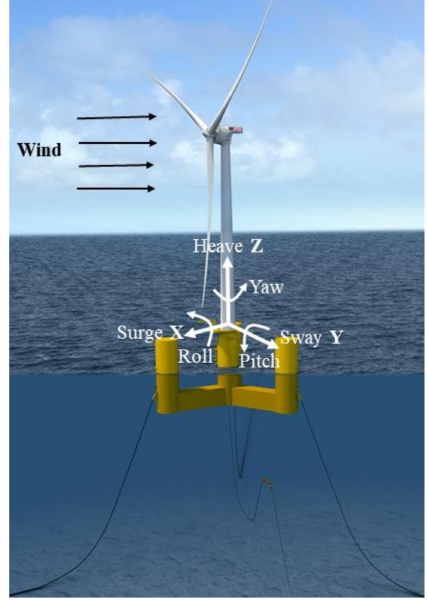
Figure 2. Six DOF for a floating platform; Reprint with permission [9]; 2019, Naval Energies.